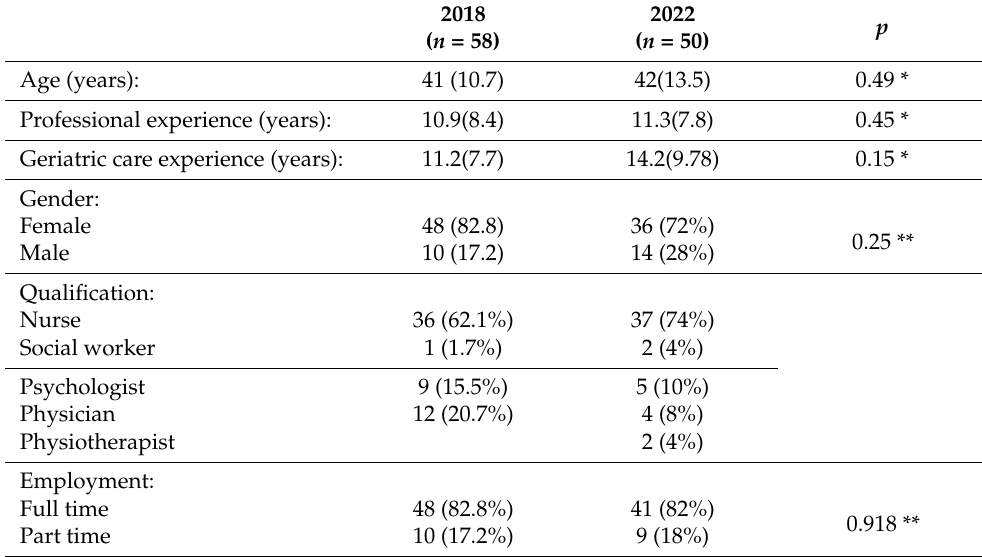
Table 1. Characteristics of the